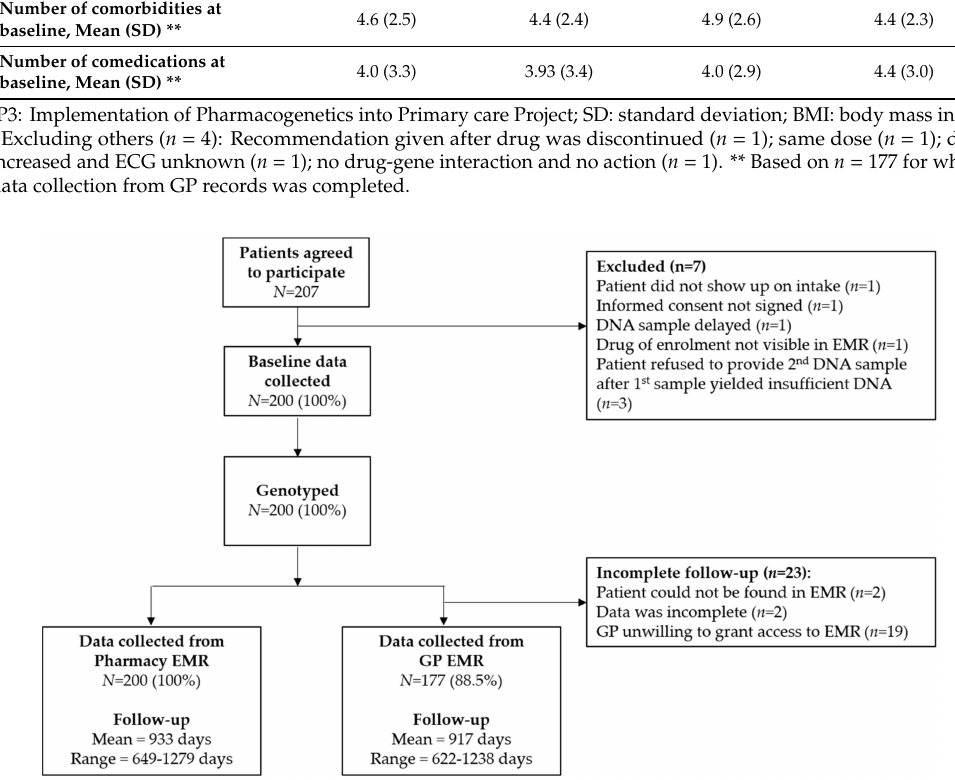
Figure 2. Flow chart or IP3 participant enrolment and